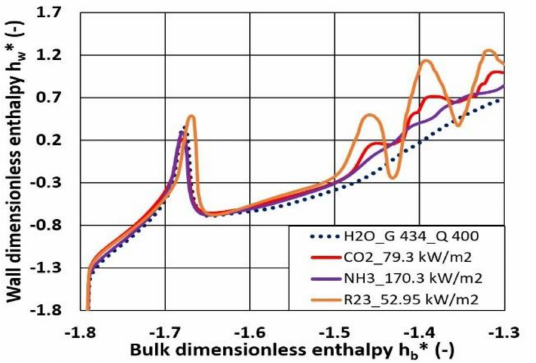
Figure 11. Predictions with the best heat fluxes for Watts’ data (Reference Case: G = 434 kg/m 2 s).